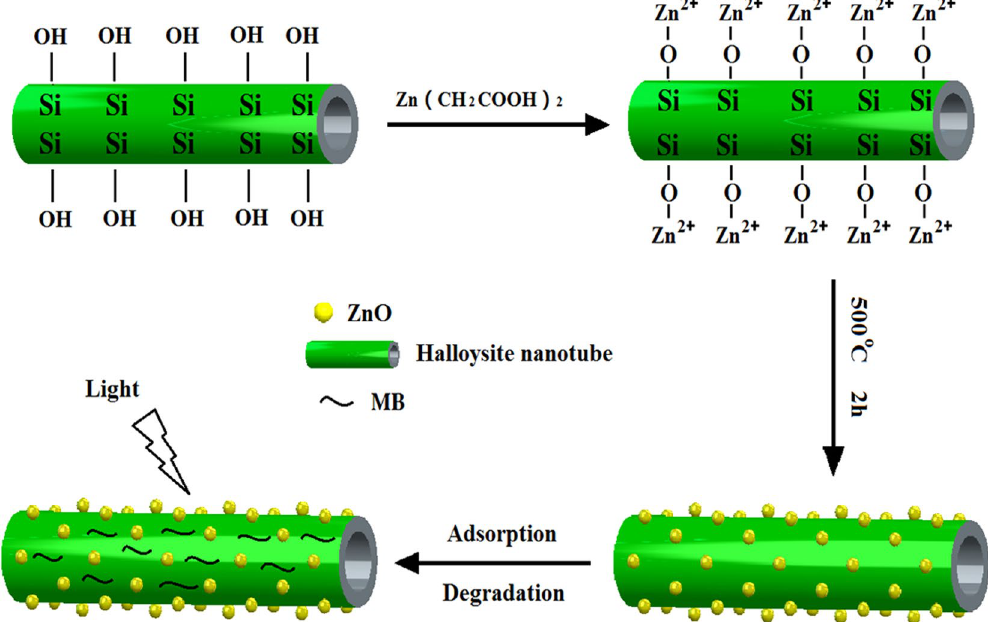
Figure 1. Illustration of the formation process of HNTs@ZnO